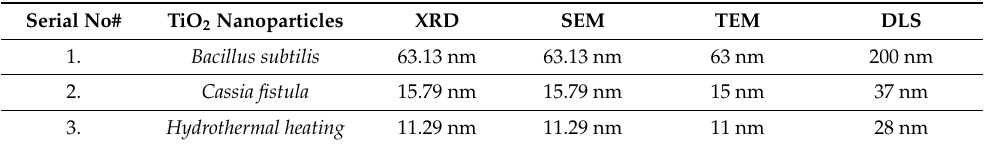
Table 1. Summary of Size calculation of different TiO 2 nanoparticles obtained by XRD, SEM, TEM and